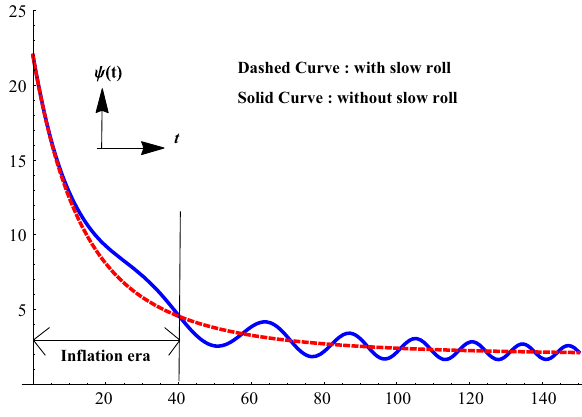
Fig. 5 q ( t ) vs. t with/without slow roll